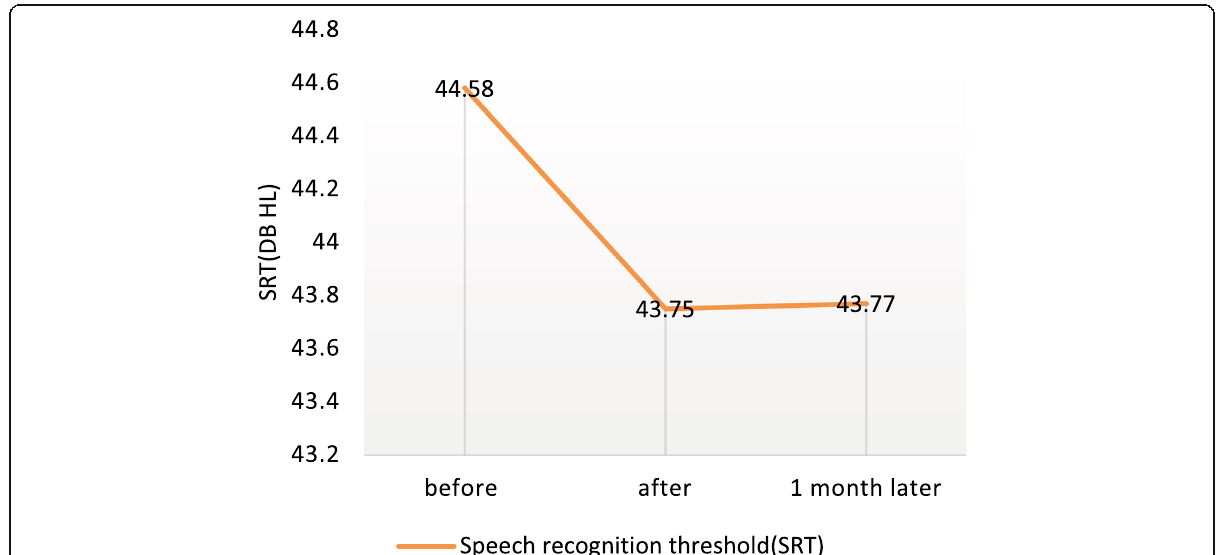
Fig. 1 The results of the repeated measures test showed that the average threshold for SRT in quiet in three measurements did not have a statistically significant difference ( P .value >